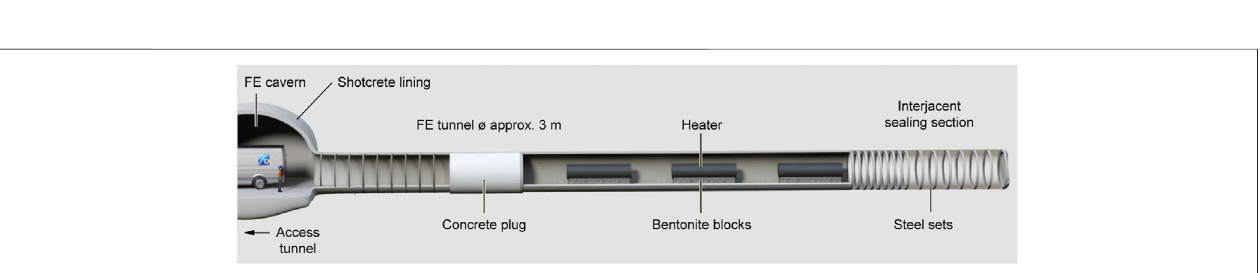
Frontiers in Earth Science |